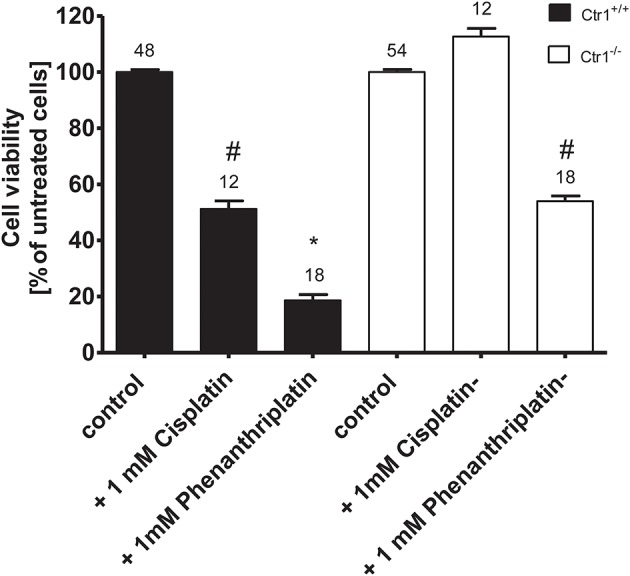
Cell viability of Ctr1+/+ and Ctr1−/− MEFs incubated with buffer (control); 1 mM phenanthriplatin or 1 mM cisplatin for 10 min. The number of experiments is listed above each column. The asterisk (*) indicates a statistically significant difference compared to the other columns, #a statistically difference compared to all the other columns except than to 1 mM cisplatin in Ctr1+/+ MEFs or to 1 mM phenanthriplatin in Ctr1−/− MEFs (ANOVA).